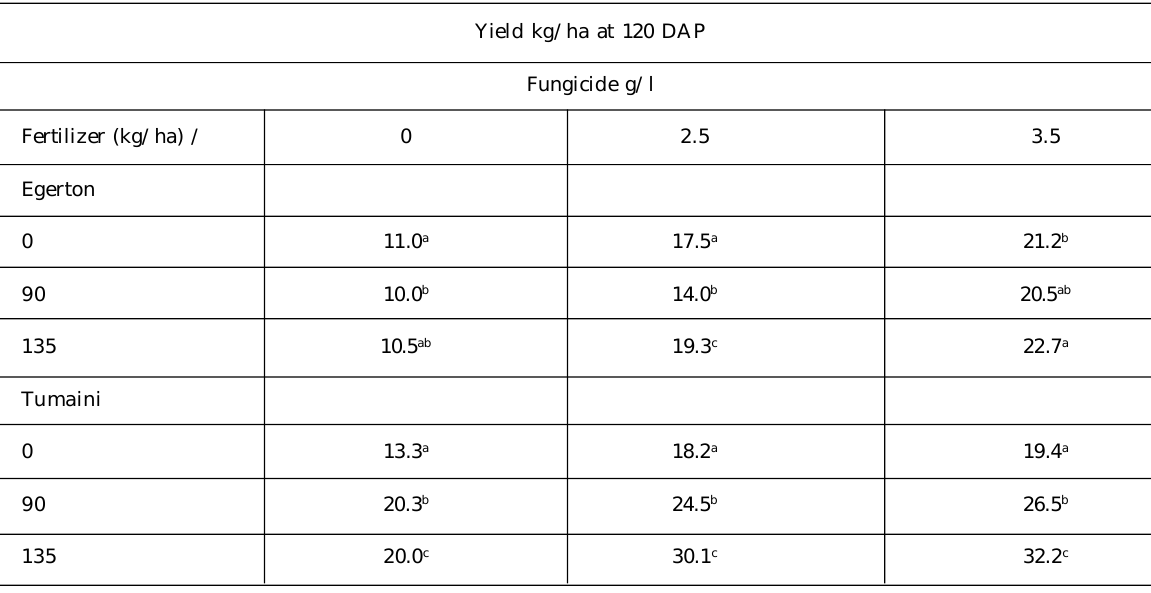
Yield kg/ha at 120 DAP Fungicide g/l